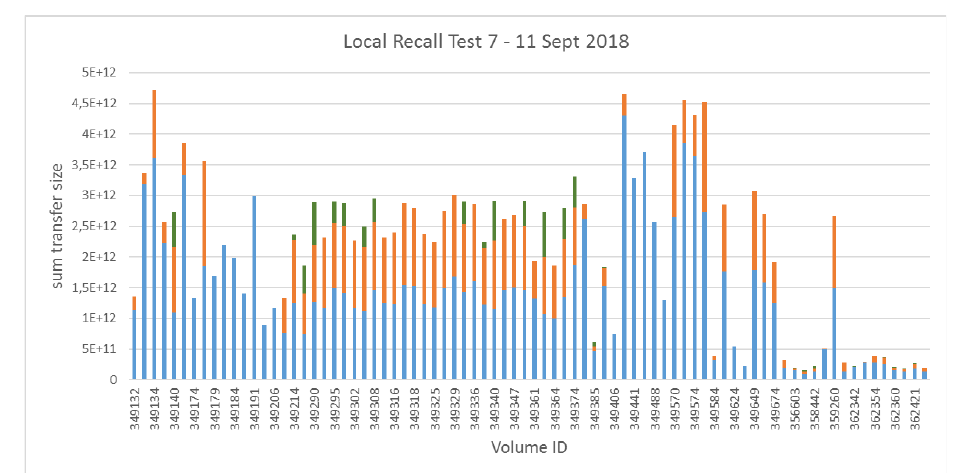
Figure 5: optimized recall test of 25 ATLAS